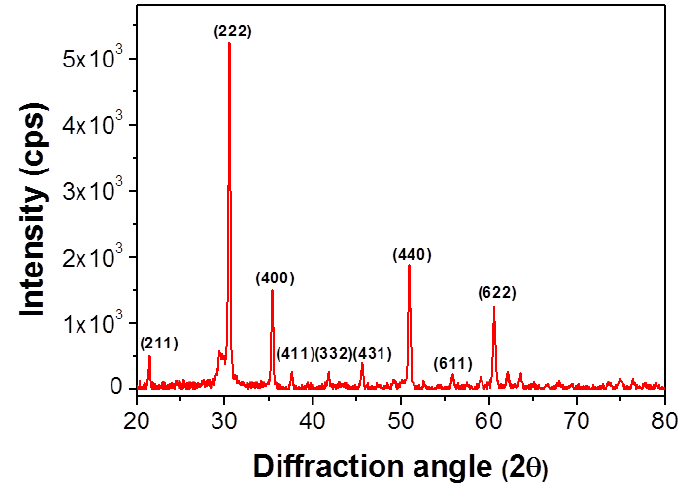
Figure 6. XRD pattern of ITO nanoparticles recovered after heat-treatment at 600 °C.